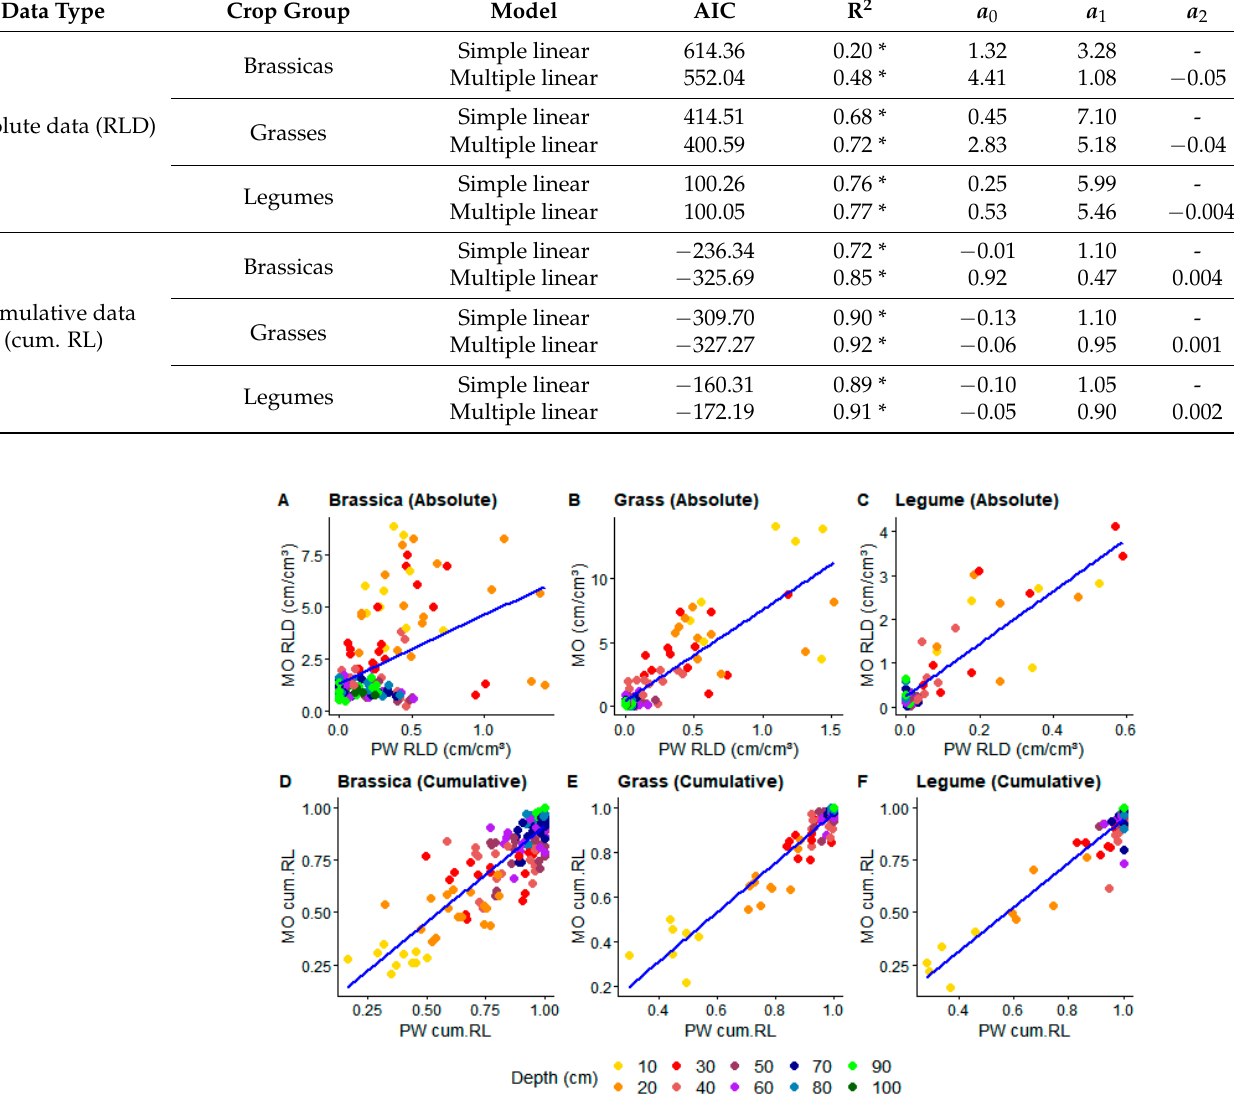
Figure 2. Multiple linear regression 3D fitting between monolith and profile wall root ‐ length density (RLD) with soil depth in training data for absolute ( A – C ) and cumulative (cum. LR) data ( D – F ). Colors show soil depth (cm) of each value. Table 3. Coefficients and quality metrics of linear regression models in training dataset, by crop group and data type. RLD, root ‐ length density and cum. RL, cumulative root ‐ length. Models are: simple linear model ( 𝑌 (cid:3404) 𝑎 (cid:2868) (cid:3397) 𝑎 (cid:2869) (cid:4666)𝑥(cid:4667)(cid:4667) and multiple linear model ( 𝑌 (cid:3404) 𝑎 (cid:2868) (cid:3397) 𝑎 (cid:2869) (cid:4666)𝑥(cid:4667) (cid:3397) 𝑎 (cid:2870) (cid:4666)𝑧(cid:4667) ), where Y, monolith method RLD or cum. RL, 𝑥 , profile wall RLD or cum. RL, 𝑧 , soil depth (cm); 𝑎 (cid:2868) ,